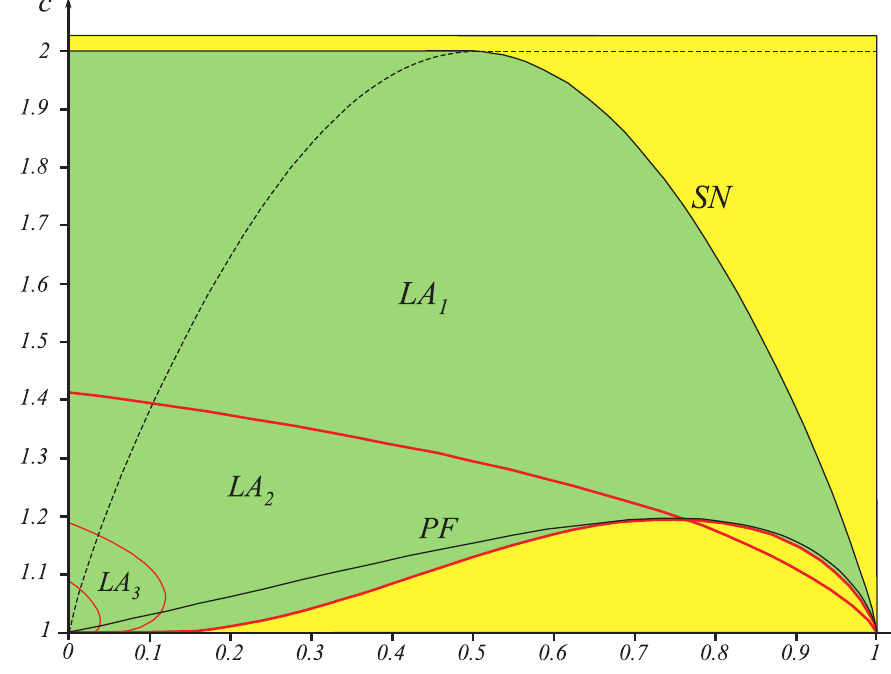
Fig. 4 The bifurcation diagram for map T c , ε . Green region correspond to the existence of Lorenz attractor.